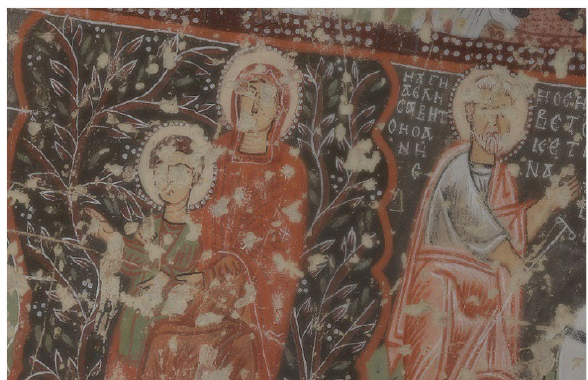
Figure 4. The current condition of the wall-Painting